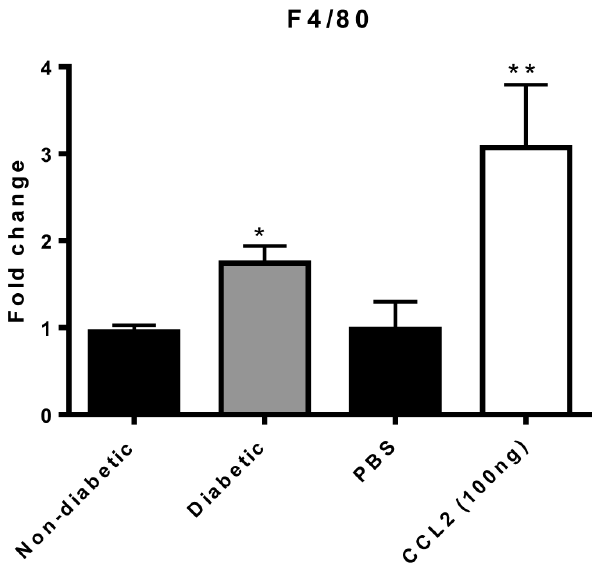
Figure 2. Diabetes or intraocular injection of CCL2 increases F4/80 expression in rat retinas. Levels of the monocyte/macro- phage associated marker F4/80 measured by qRT-PCR in 4 week non- diabetic or diabetic rat retinas and rats receiving an intraocular injection of either PBS or CCL2 (n=4 animals in each group). * Significantly greater than control non-diabetic (p=0.01). ** Significantly greater than PBS injected (p=0.035).